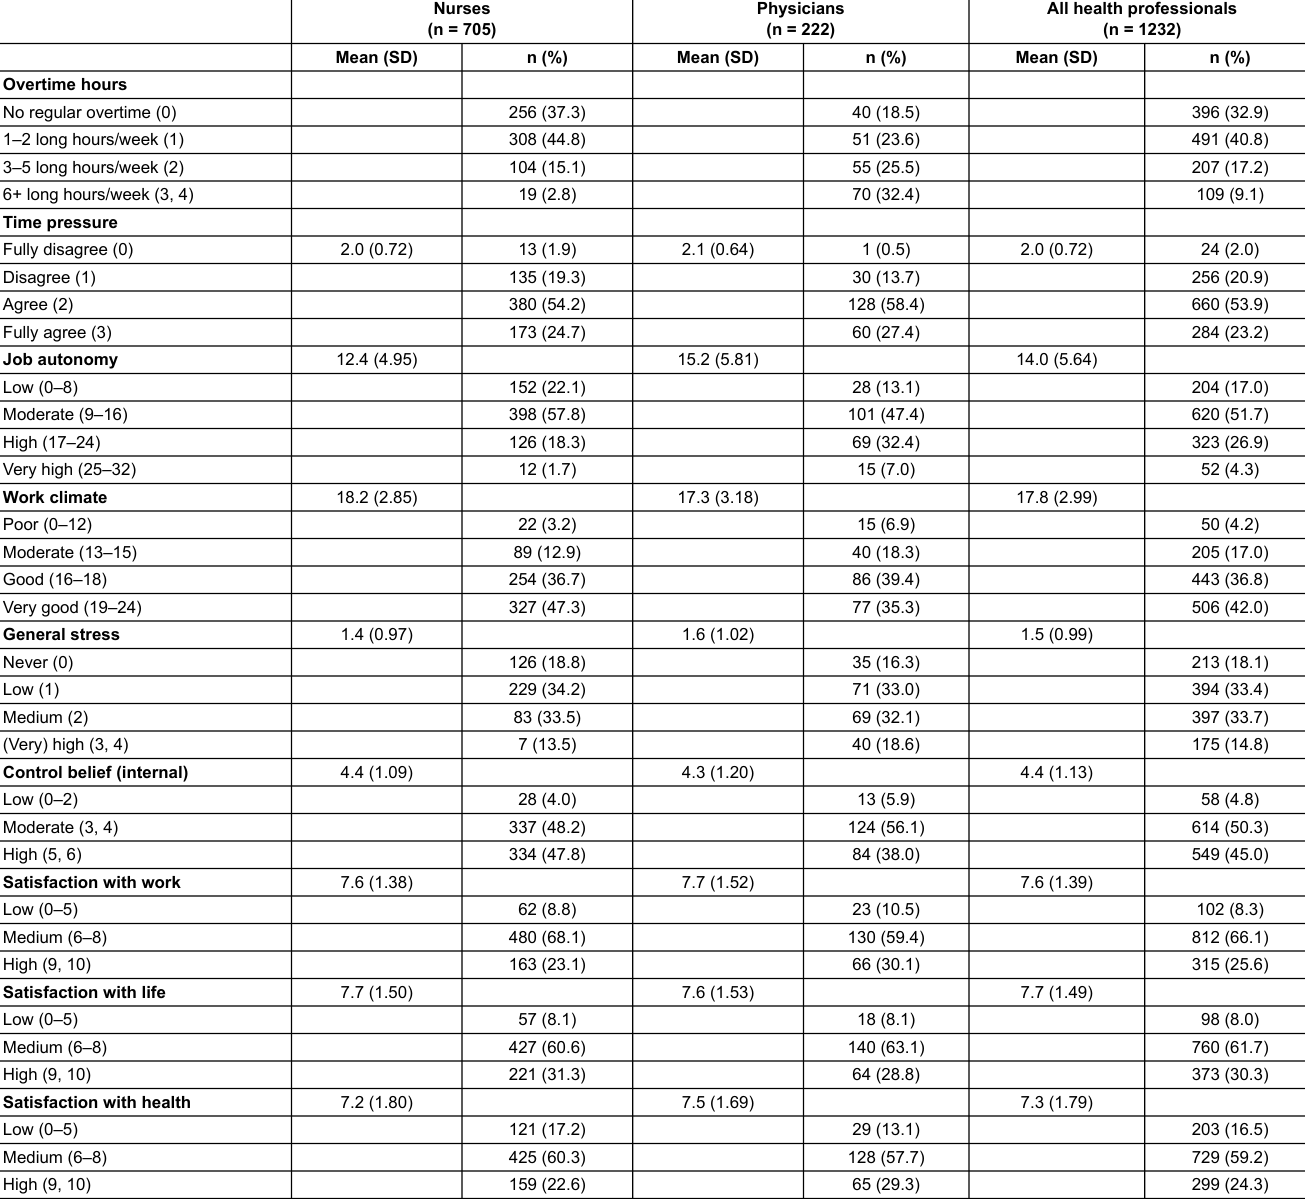
Table 2: Temporal work stressors, organisational and personal resources, general stress and satisfaction among health